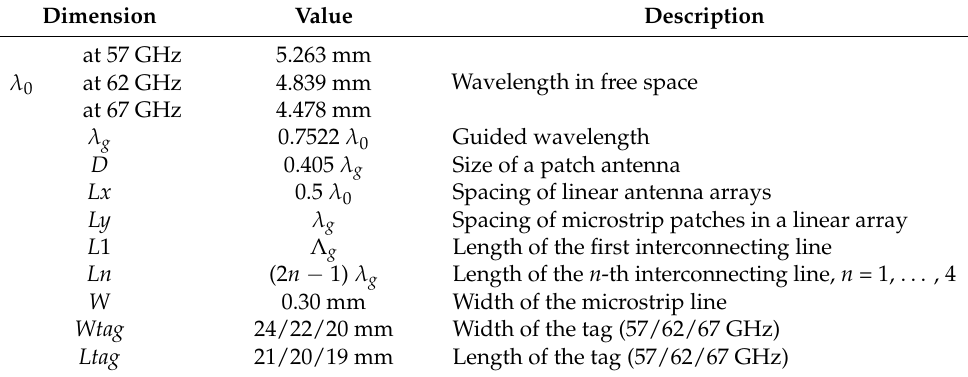
Table 1. Co-polarized tag